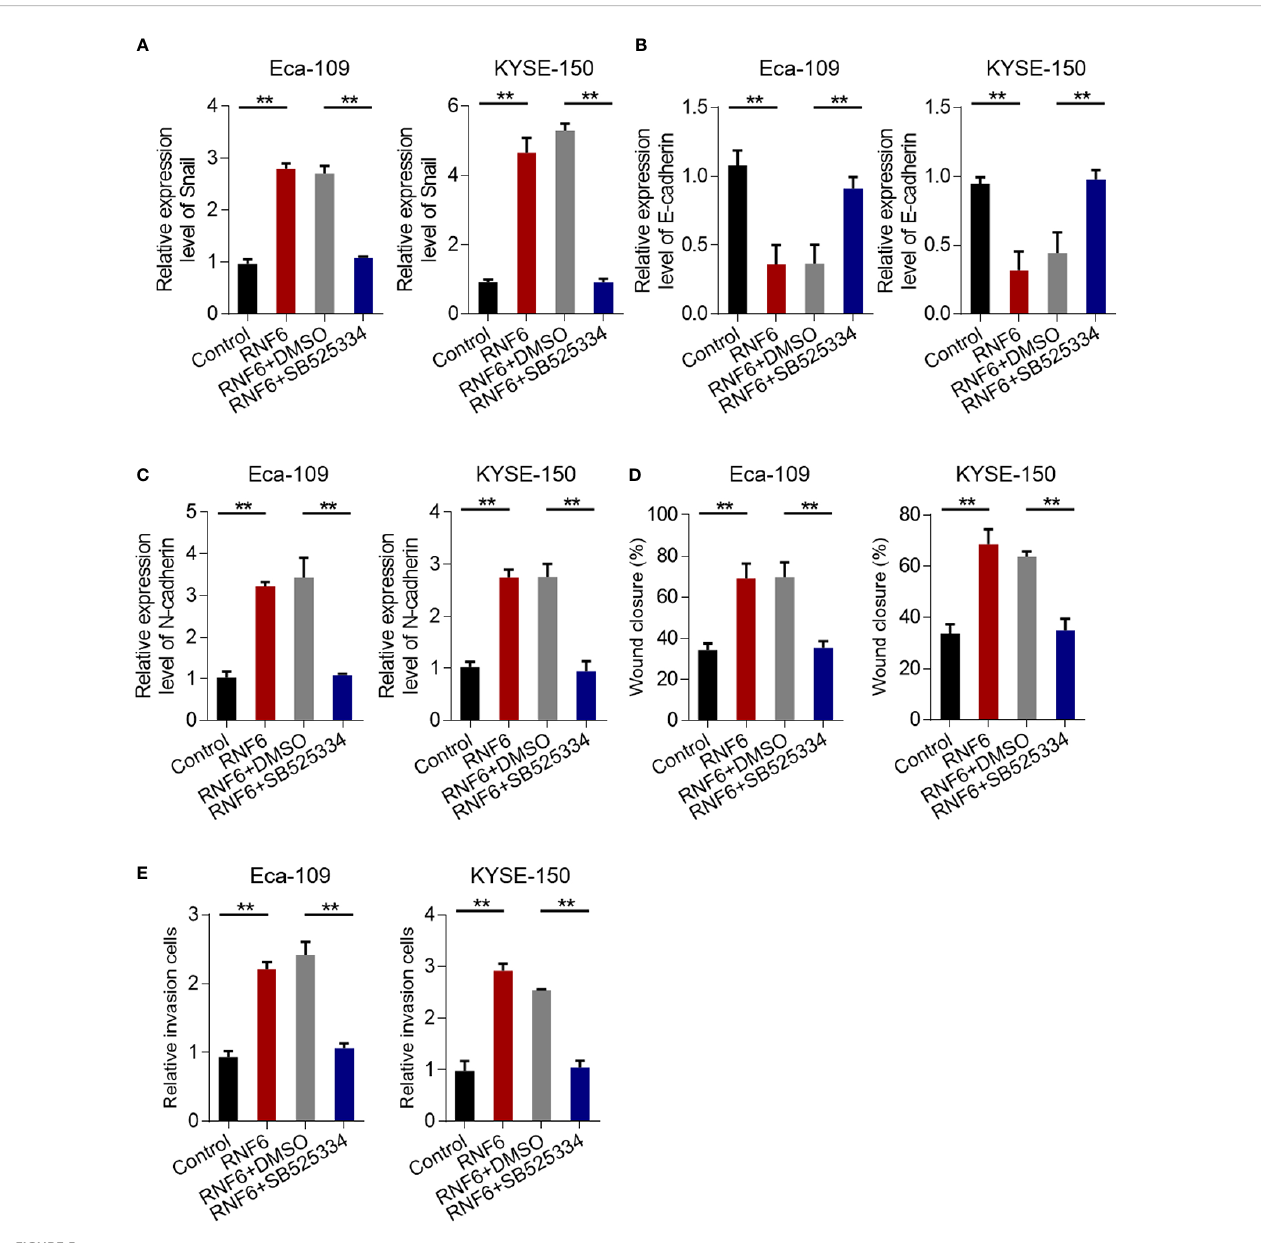
FIGURE 5 TGF- b inhibitors reverse the cancer-promoting effects of RNF6. (A) qPCR analysis of Snail mRNA levels in Eca-109 and KYSE-150 cells overexpressed with RNF6 or treated with SB525334 (a TGF- b inhibitor). (B) qPCR analysis of E-cadherin mRNA levels in Eca-109 and KYSE-150 cells overexpressed with RNF6 or treated with SB525334. (C) qPCR analysis of N-cadherin mRNA levels in Eca-109 and KYSE-150 cells overexpressed with RNF6 or treated with SB525334. (D) Effects of SB525334 and RNF6 upregulation on cell migration. (E) Effects of SB525334 and RNF6 upregulation on cell invasion. n=3, **P < 0.01, ANOVA